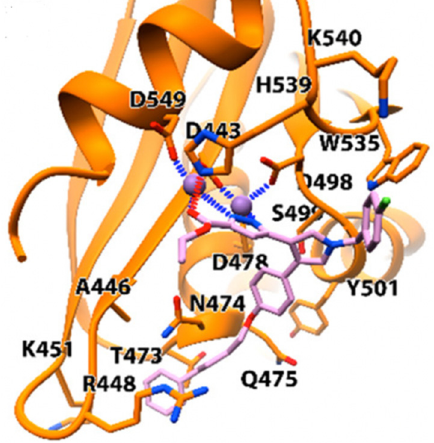
Figure 12. The nitrogen of pyrazole ring and ester moiety formed ligands with two interaction with H539, while the substituted benzyl group was possibly linked with W535 and K540 by π –cation interaction. The phenyl moiety was linked with Y501, S499, Q475, E478, N474, and Q475. The scaffold exhibited high potency with the HIV-1 RT pocket and could be optimized for drug development. be optimized for drug development.